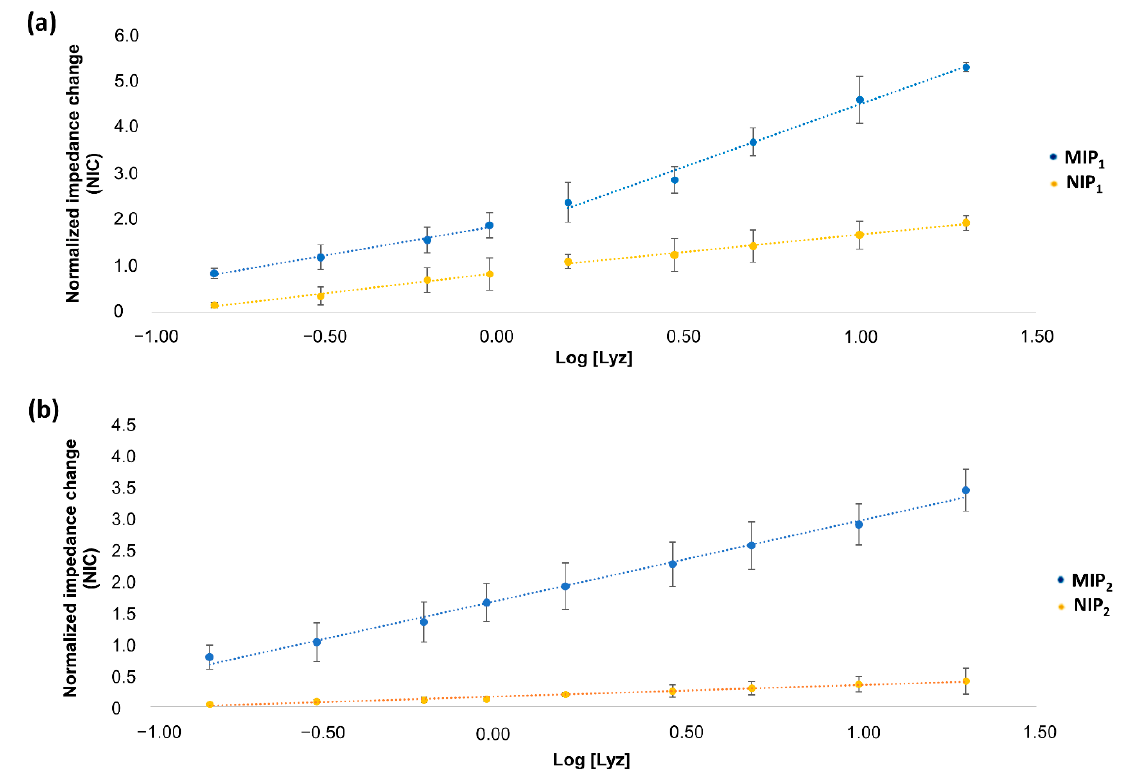
Figure 6. ( a ) Calibration curve for MIP 1 and NIP 1 ; ( b ) calibration curve for MIP 2 and NIP 2 . Each point of the calibration curve is referred to the average of three replicates on three freshly prepared sensors.